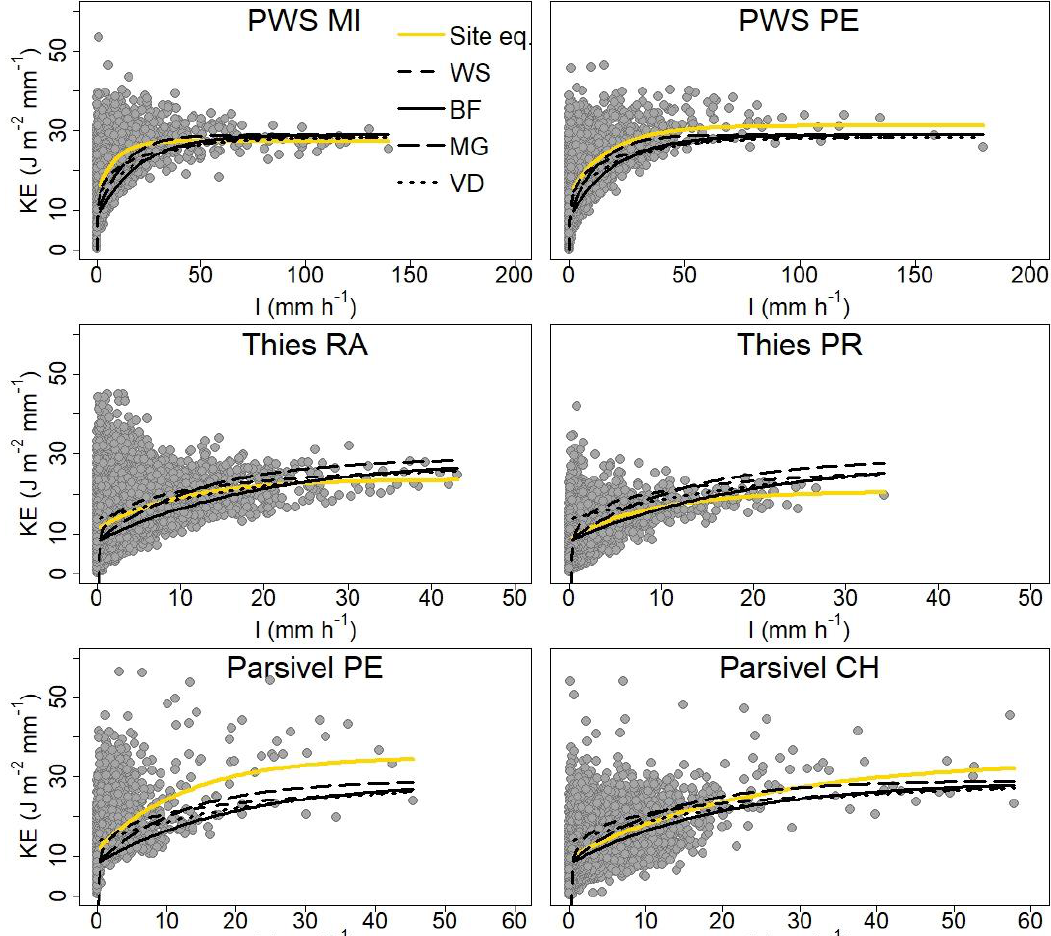
Figure 4. Rainfall kinetic energy per unit area and unit rainfall plotted against rainfall intensity for each disdrometer and site, and comparison of the developed rainfall kinetic energy – intensity relationships and the rainfall kinetic energy – intensity relationships Wischmeier and Smith (WS); Brown and Foster (BF); McGregor et al. (MG); and van Dijk et al. (VD) from the literature. Notes: MI = Mistelbach; PE = Petzenkirchen; RA = Rauchenwarth; PR = Prague; and CH = Christchurch.